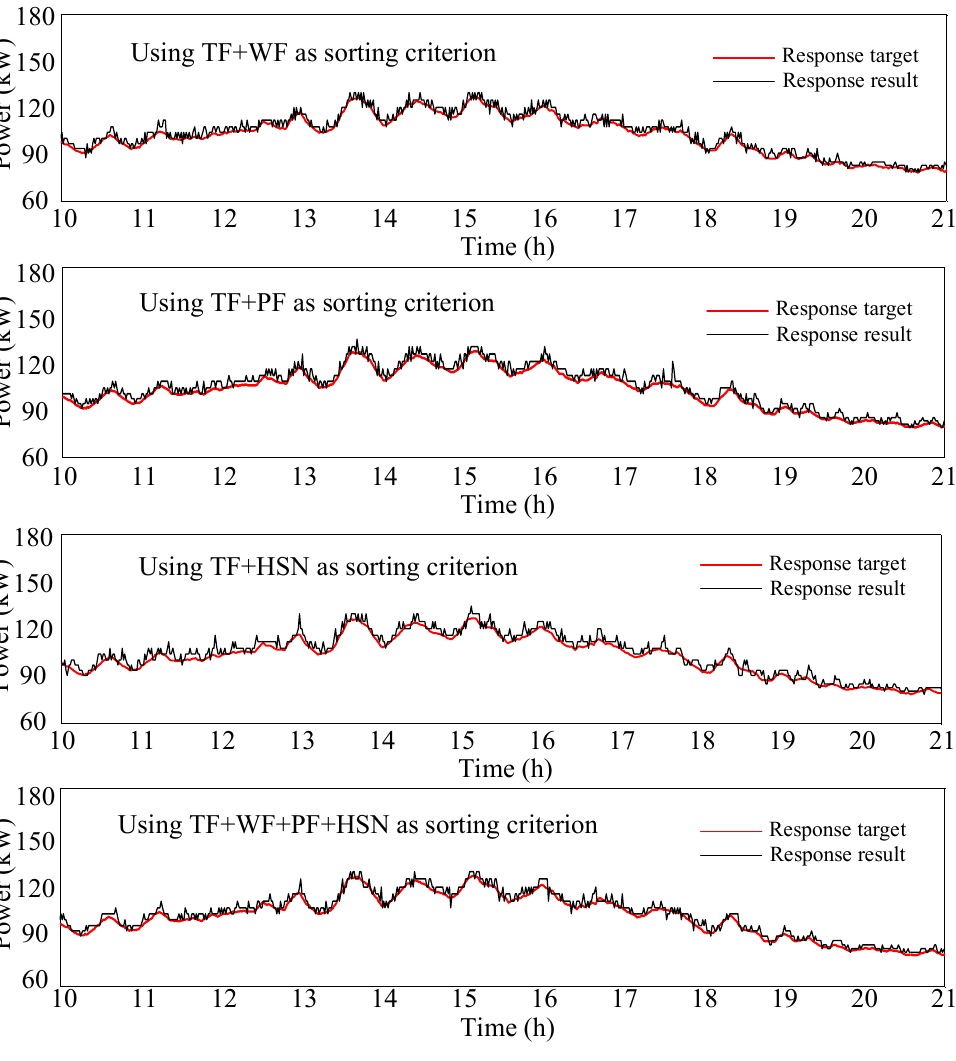
Figure 22. Response results comparison under multiple sorting criterion.